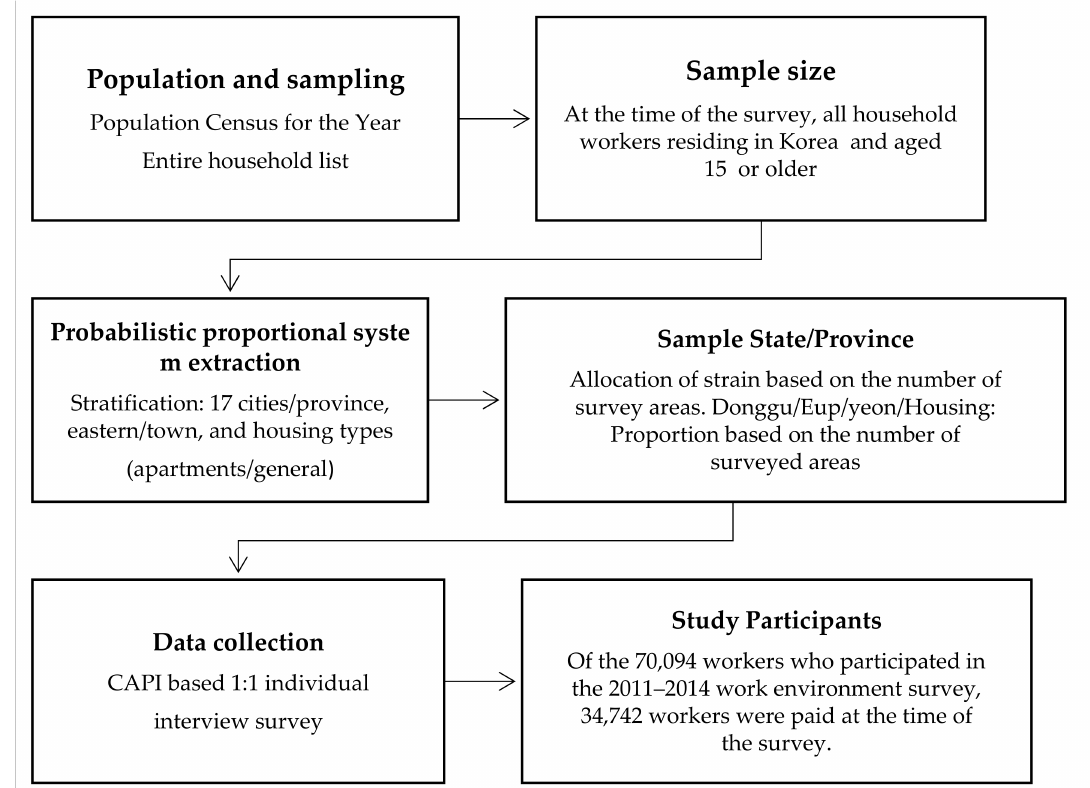
Figure 1. Sample Design Procedure of the